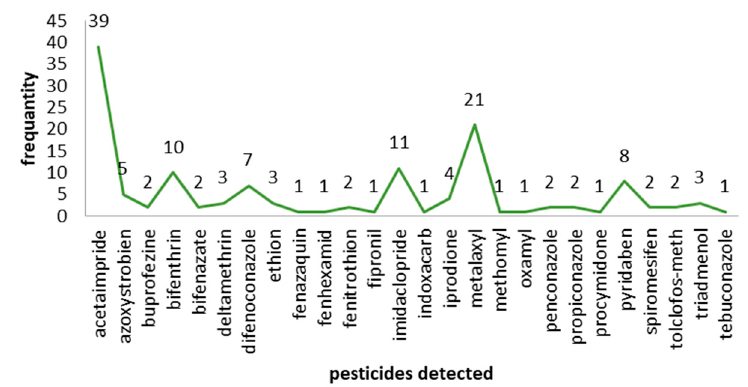
Figure 2. Frequency of occurrence of pesticides.